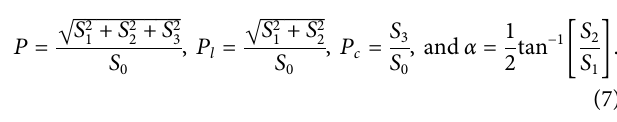
Frontiers in Physics |